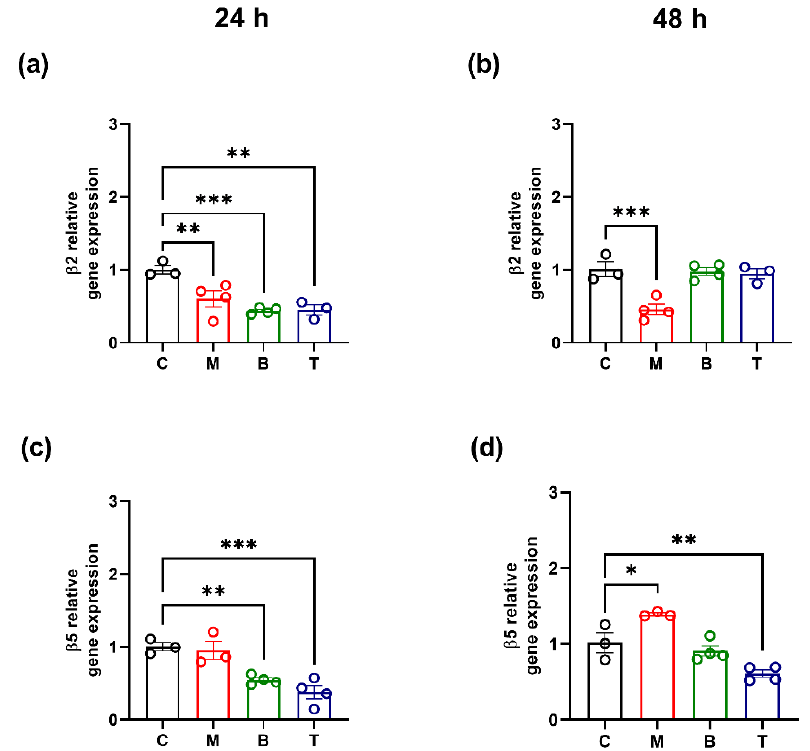
Figure 5. Relative gene expression of β 2 ( a , b ) and β 5 ( c , d ) subunits after treatment with 10 µ M morphine (M), 0.25 µ M buprenorphine (B) or 10 µ M tapentadol (T) in SH-SY5Y cells at 24 h ( a , c ) and 48 h ( b , d ). Data, expressed as the mean ± SEM of three/four biological replicates per treatment, represent 2 − DDCt values and are analyzed by one-way ANOVA followed by Dunnett’s multiple comparisons test (* p < 0.05; ** p < 0.01; *** p < 0.001 vs. control (C)).